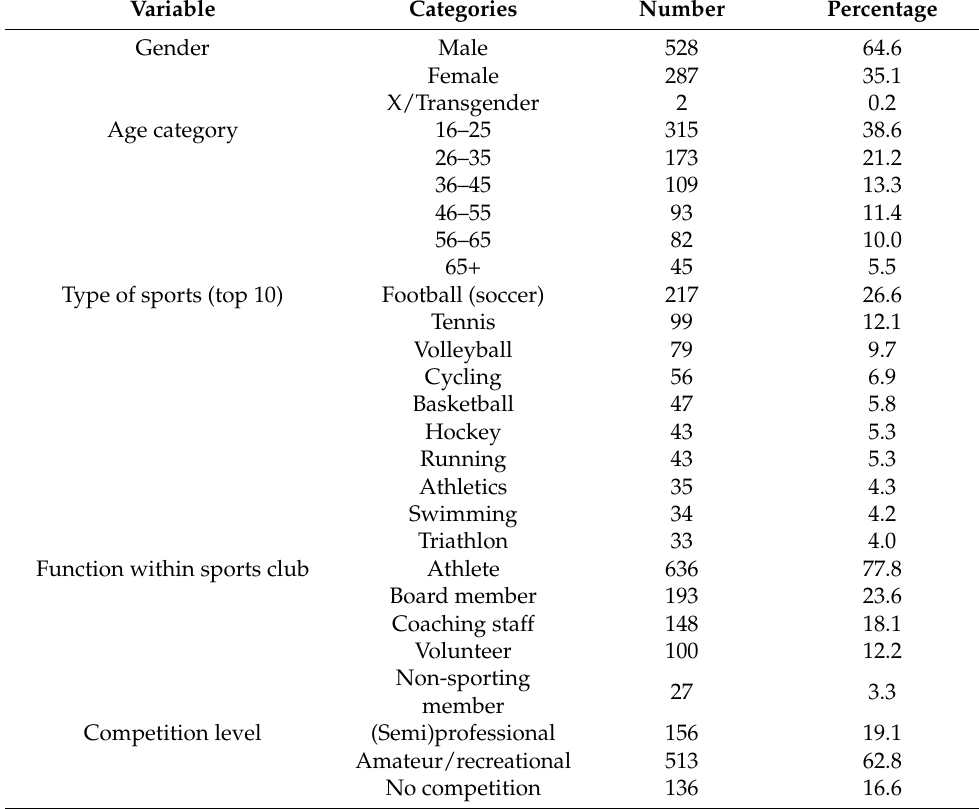
Table 1. Sociodemographic characteristics of the study’s sample ( n = 817).